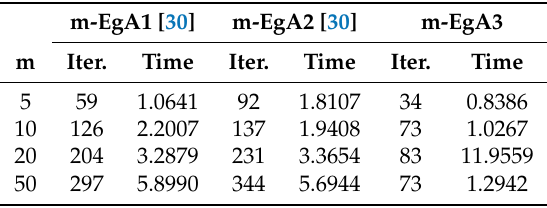
Table 1. Numerical results numeric values for Figures 1–8.